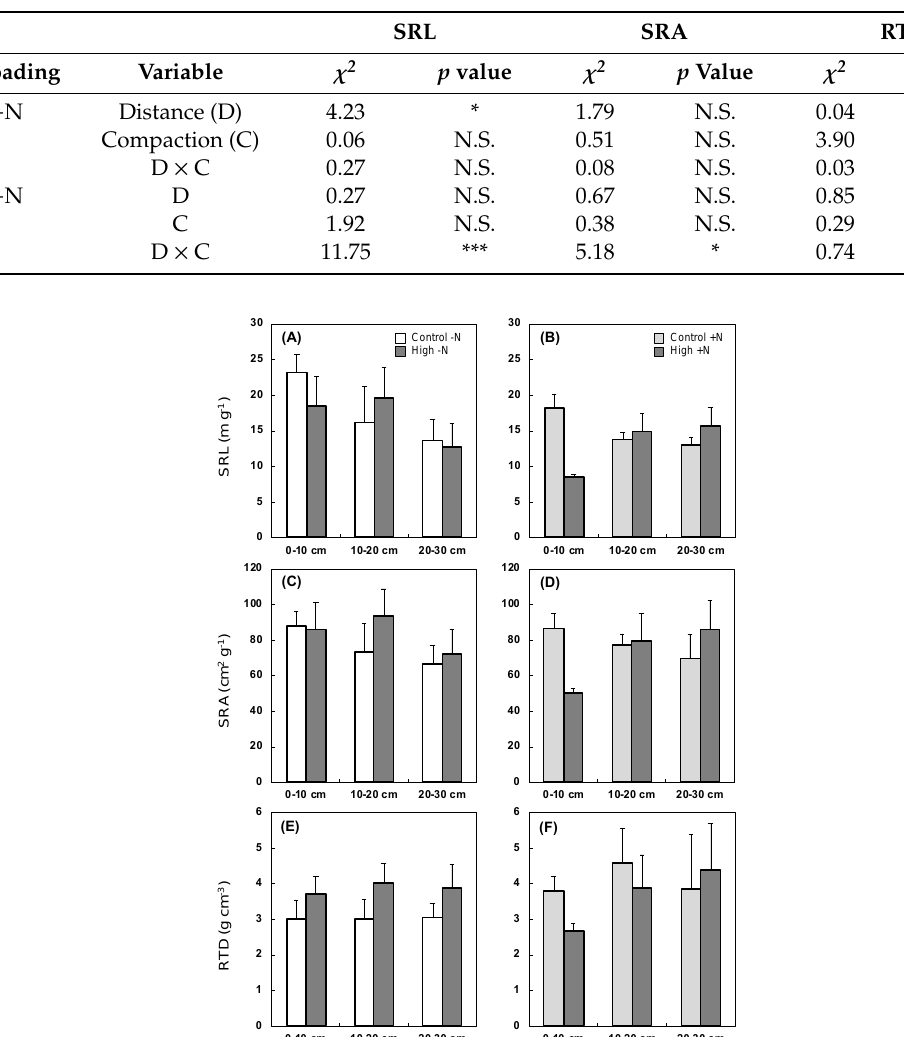
Table 4. Results of relative abundance (%) for top five in associated ECM under soil compaction and N loading ( n = 5). The identified fungal taxa were described as genus level.